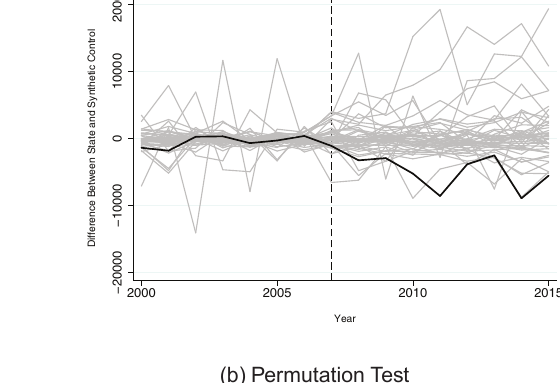
Figure A26 Size of immigrant workforce (female) in household service occupations